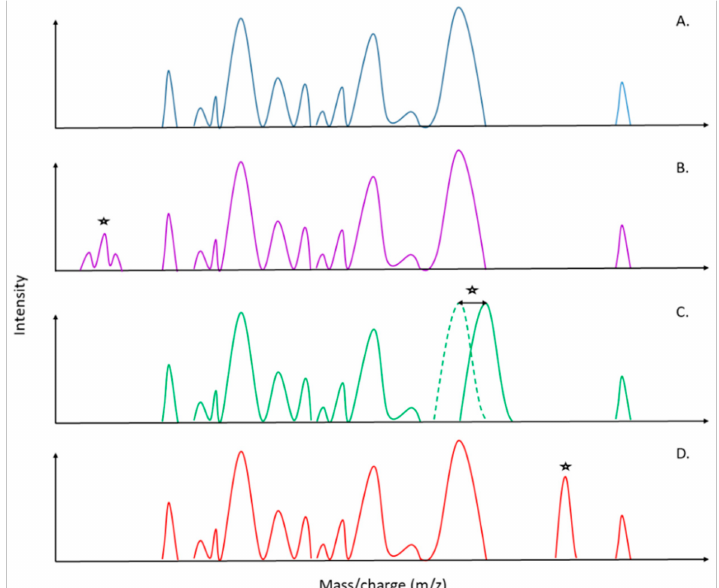
Figure 2. Schematic representation of possible MALDI-TOF MS spectra patterns for direct determination and identification of antimicrobial resistance. ( A ) Sensitive strain. ( B ) Detection of antimicrobial resistance by the detection of metabolites related to the degradation of the antibiotic. ( C ) Detection of antimicrobial resistance by the detection of a peak shift, which could be related to a mutation in the biomarker gene that confers antimicrobial resistance (AMR). ( D ) Detection of antimicrobial resistance by the detection of unique biomarkers, which could be related to the production of a specific molecule (e.g., enzymes, porins). (*) Peak di ff erences in comparison with the sensitive strain spectra ( A